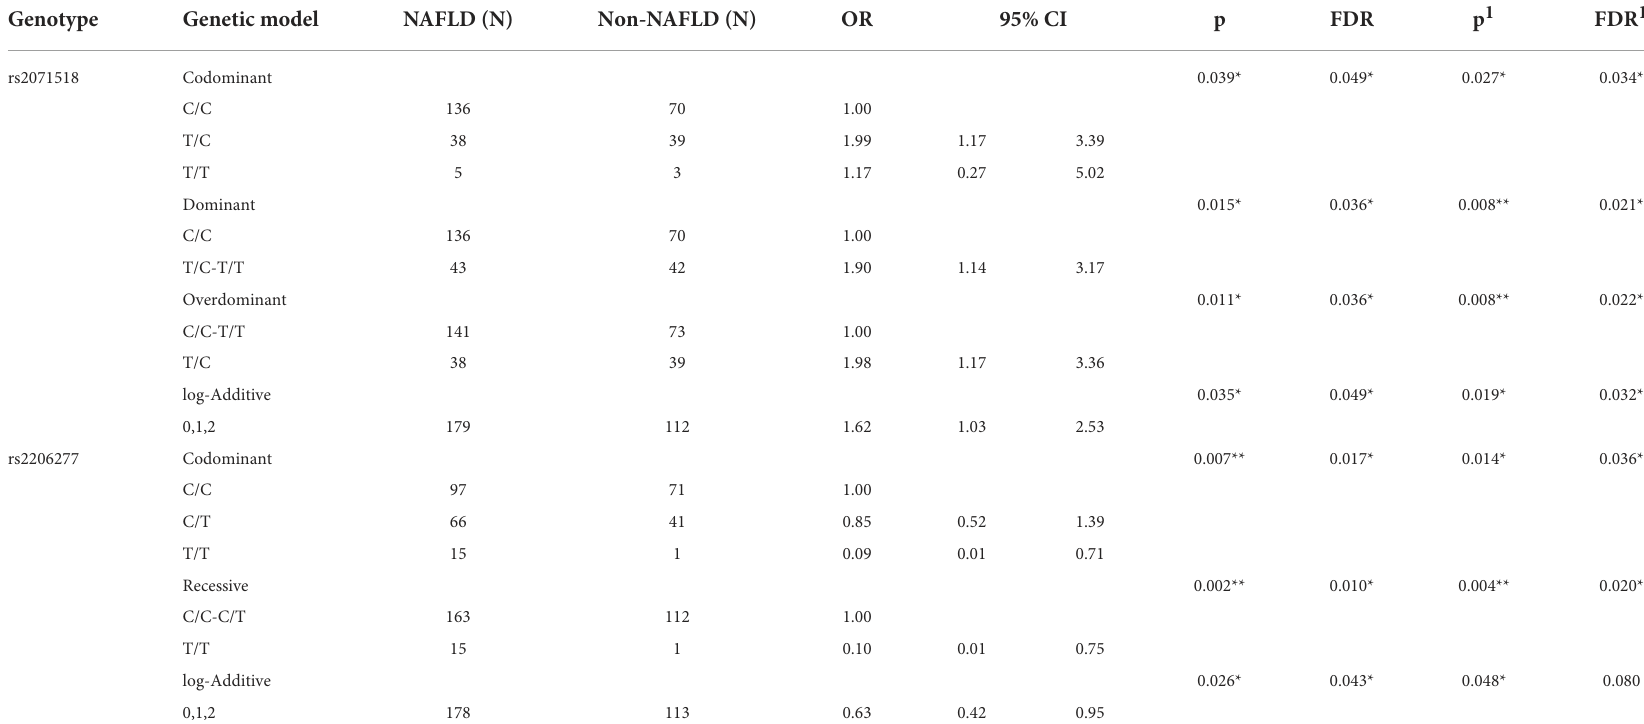
TABLE 5 Genotype distribution in five genetic models in males.